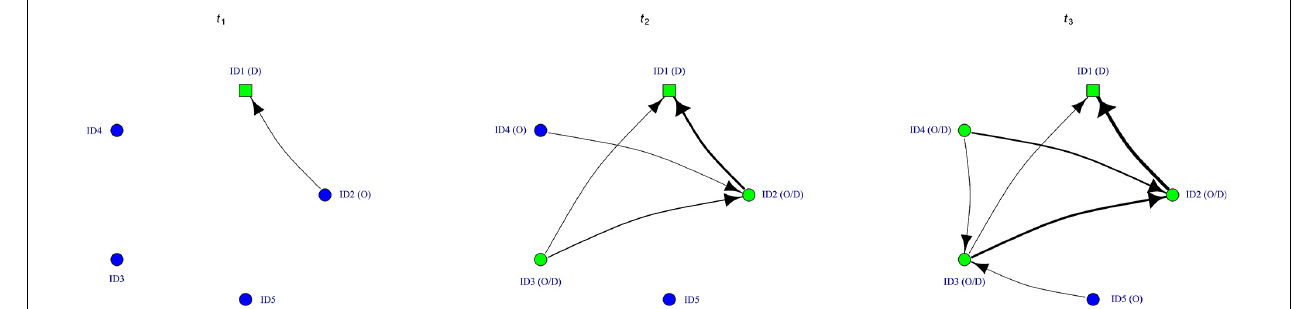
FIGURE 2 | Potential application of a “demonstration network.” Nodes represent individuals (circular arrangement of the nodes do not reflect individual spatial positions); directed weighted links between nodes denote the frequency or duration of getting within the perception range of another individual (i.e., potential observation opportunities). The square symbol indicates the individual that responds to an environmental cue, circles denote all other individuals in the study area. Color of the nodes denote whether or not an individual altered its behavior within given period (green versus blue). At t 1 , ID1 detect a relevant environmental cue and adjusts its behavior accordingly. By doing so, ID1 produces a social cue that is detectable to others. Thus, t 1 represents the first exhibition of the target behavior by ID1. At t 2 , ID2, and ID3 also exhibit this behavioral response and become social information producers themselves. At t 3 , ID4 also shows the relevant behavioral adjustment. Each of these sets of connections (observed in the 0- t 1 , 0- t 2 , and 0- t 3 periods, respectively) is characteristic for the individual(s) that performed the target behavior at t i . All connections together represent a demonstration network, which can be split into a series of time-aggregated networks using the time points t i as threshold values. With the application of NBDA on these series, one may investigate whether observation opportunities, expressed as standardized rates, accelerate the diffusion of the studied behavioral response among individuals. In order to do that, NBDA has to be modified to take the series of time-aggregated networks (e.g., as a list object) as input data. Factors that may influence information exchange through such connections are discussed in the “Criteria for the diffusion of social information” section. We used the igraph (Csardi and Nepusz, 2006) and tnet (Opsahl, 2009). R packages to draw the